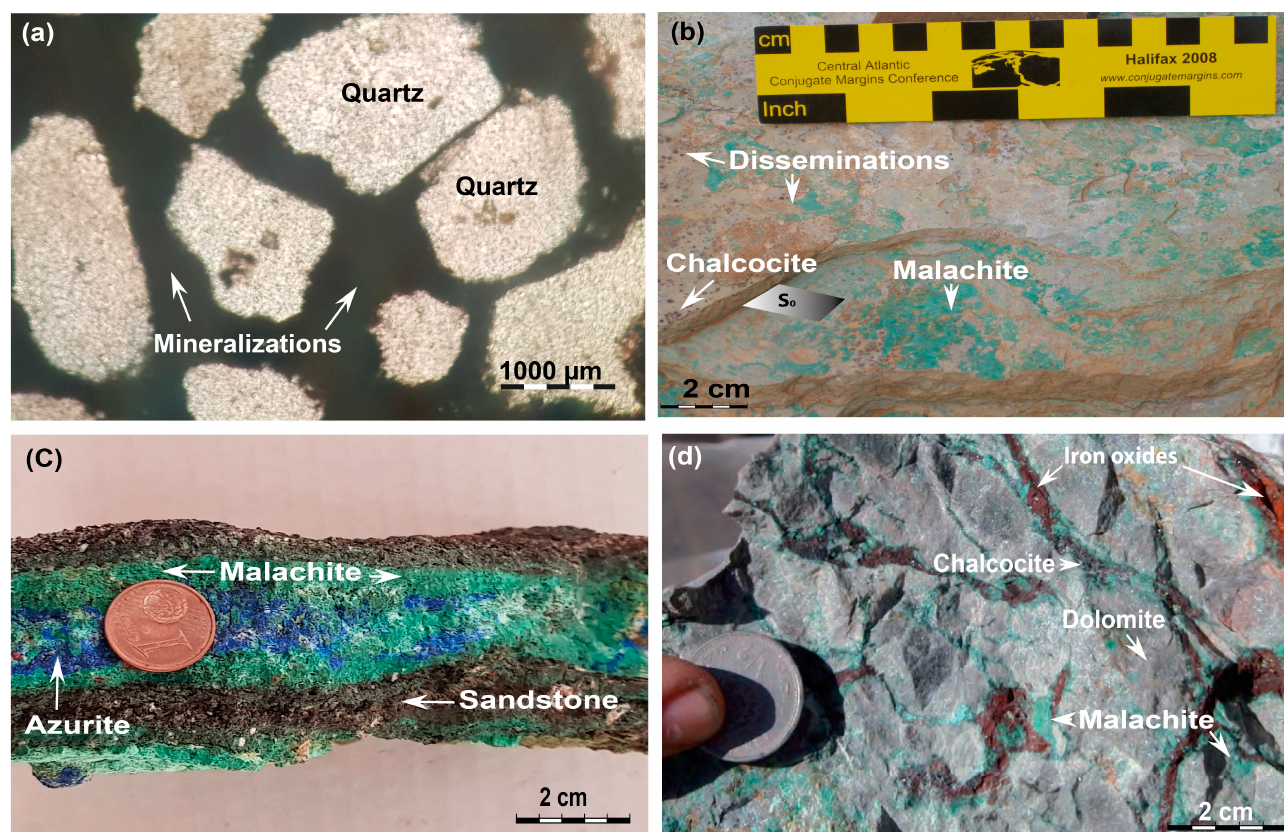
Figure 9. Main structure of the stratiform copper ores in the Anti-Atlas Paleozoic sedimentary. ( a ) Microscopic view of the cupriferous ore filling intragranular spaces of the sandstone facies of the “Série de base” Formation (Tazalaght deposit). ( b ) Structural karst-tectonic cavities in dolomite filled with oxidized chalcocite to malachite and iron oxides (Agjgal deposit, Maddi et al. [14]). ( c ) bands of malachite and azurite conformable to bedding (Tazalaght deposit). ( d ) Malachite veneers and chalcocite grains lining the Adoudounian limestone stratification planes north of Tayfast (Central Anti-Atlas).